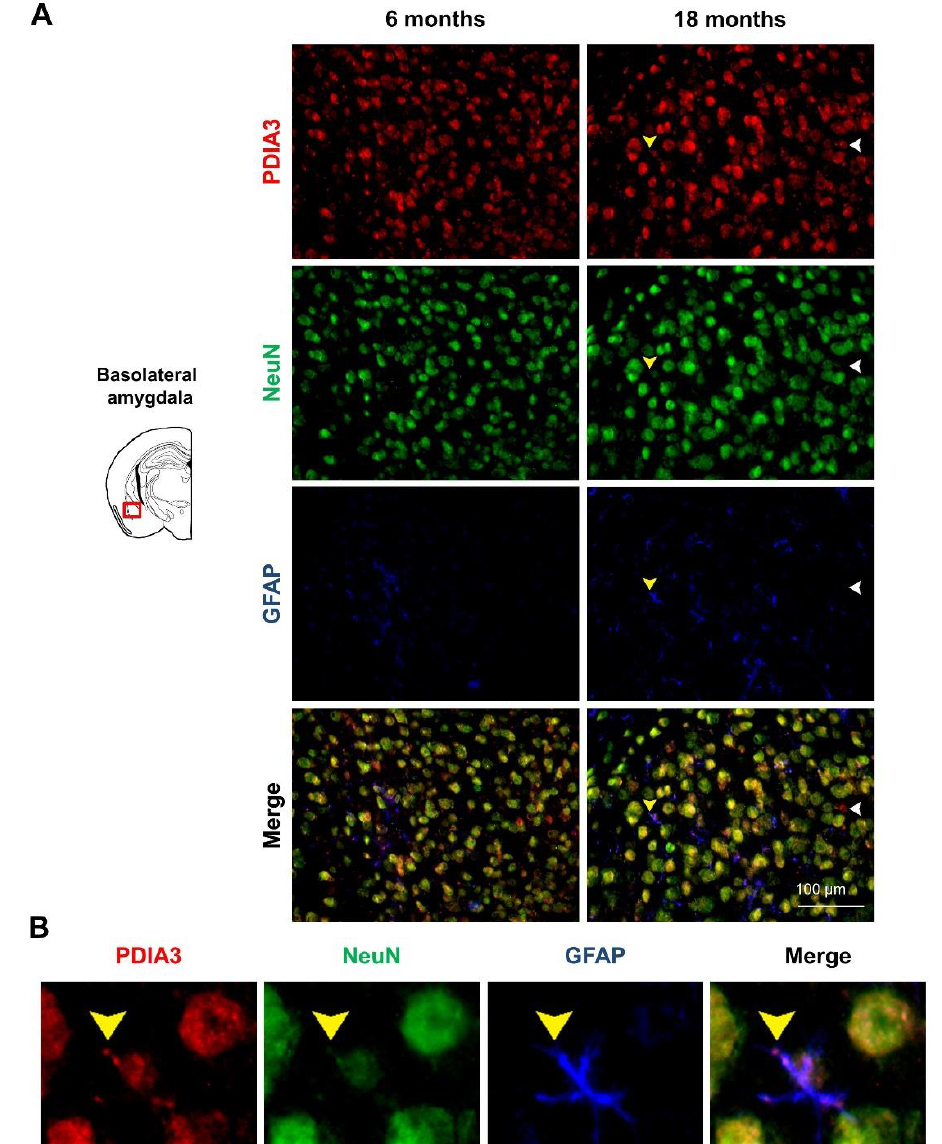
Figure 6. PDIA3-NeuN-GFAP protein levels observed in the basolateral amygdala of 3 × Tg-AD mice: ( A ) Representative microphotographs of PDIA3-NeuN-GFAP triple-fluorescent immunostaining (red, green, and blue, respectively) performed on brain slices of the basolateral amygdala collected from 6- and 18-month-old 3 × Tg-AD mice. The white arrows indicate the PDIA3 single-positive cells while the yellow arrows indicate the PDIA3-GFAP co-localization. Original magnification: 20 × ; scale bar was set at 100 µ m; ( B ) Representative microphotographs of PDIA3-GFAP co-localization in astrocytes from basolateral amygdala of 18-month-old 3 × Tg-AD mice.